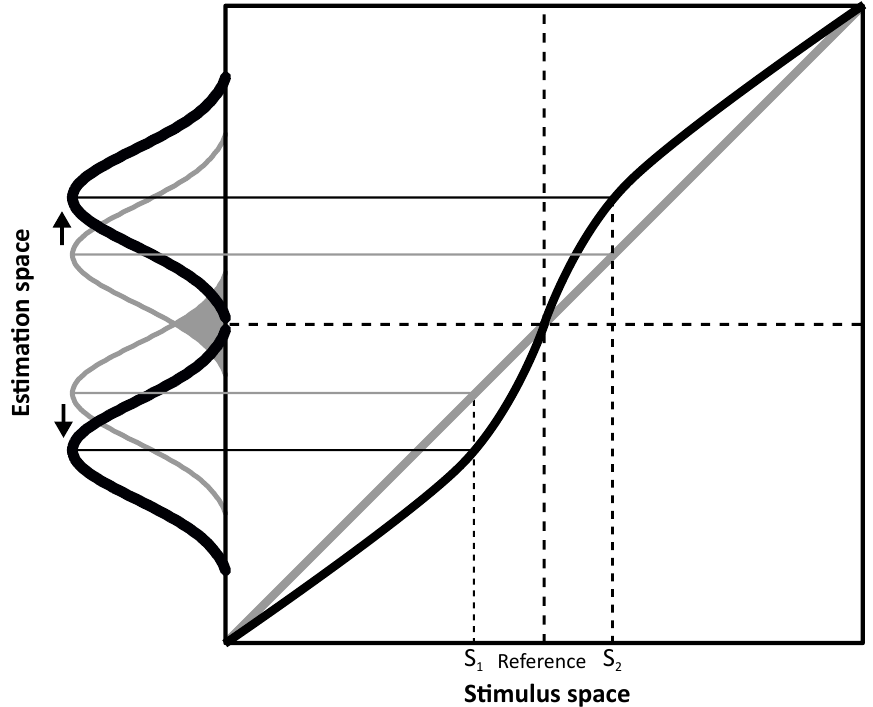
Figure 1. Representation of unbiased (in gray) and biased (in black) perceptual systems. The diagonal unbiased gray line shows a system where estimates are identical to the stimulus value. Biases in the thick black line are shown by the deviation of the estimates from the diagonal which is reflected in a repulsion from the reference. Figure is inspired by